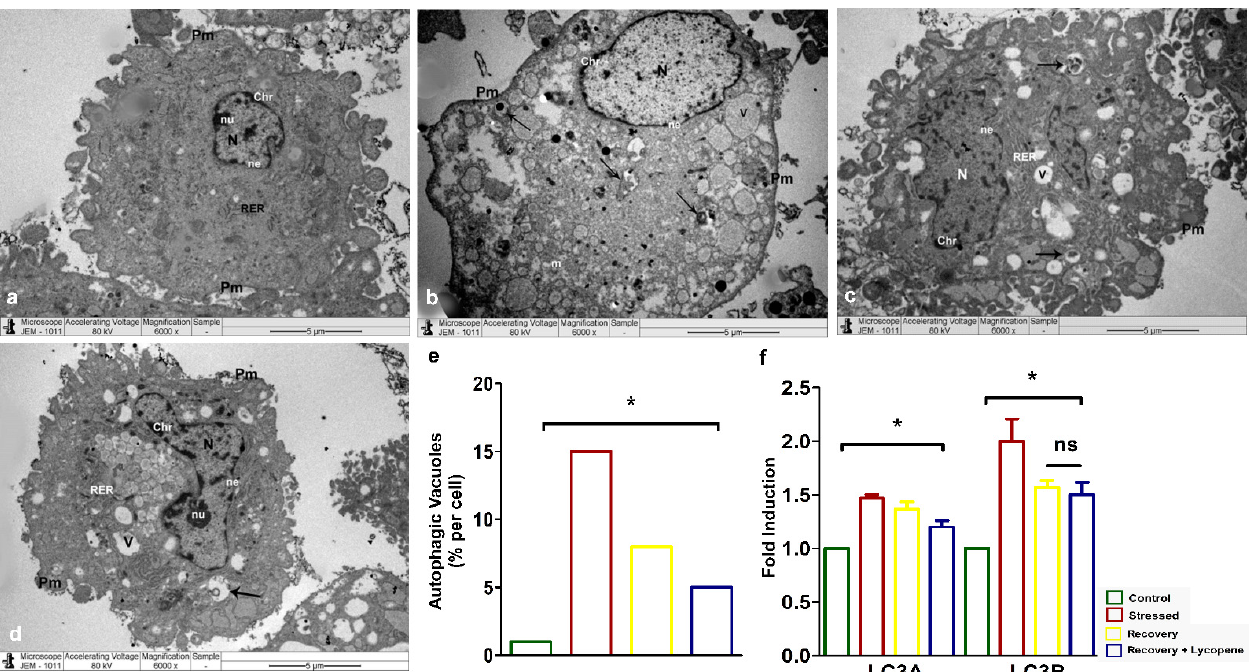
Figure 2. ( a – d ) TEM showing accumulation of autophagic vacuoles. ( e ) Quantitation of autophagic vacuoles in % ( p < 0.0158) . ( f ) LC3A and LC3B autophagic markers by RT-PCR (LC3a— p < 0.0187,